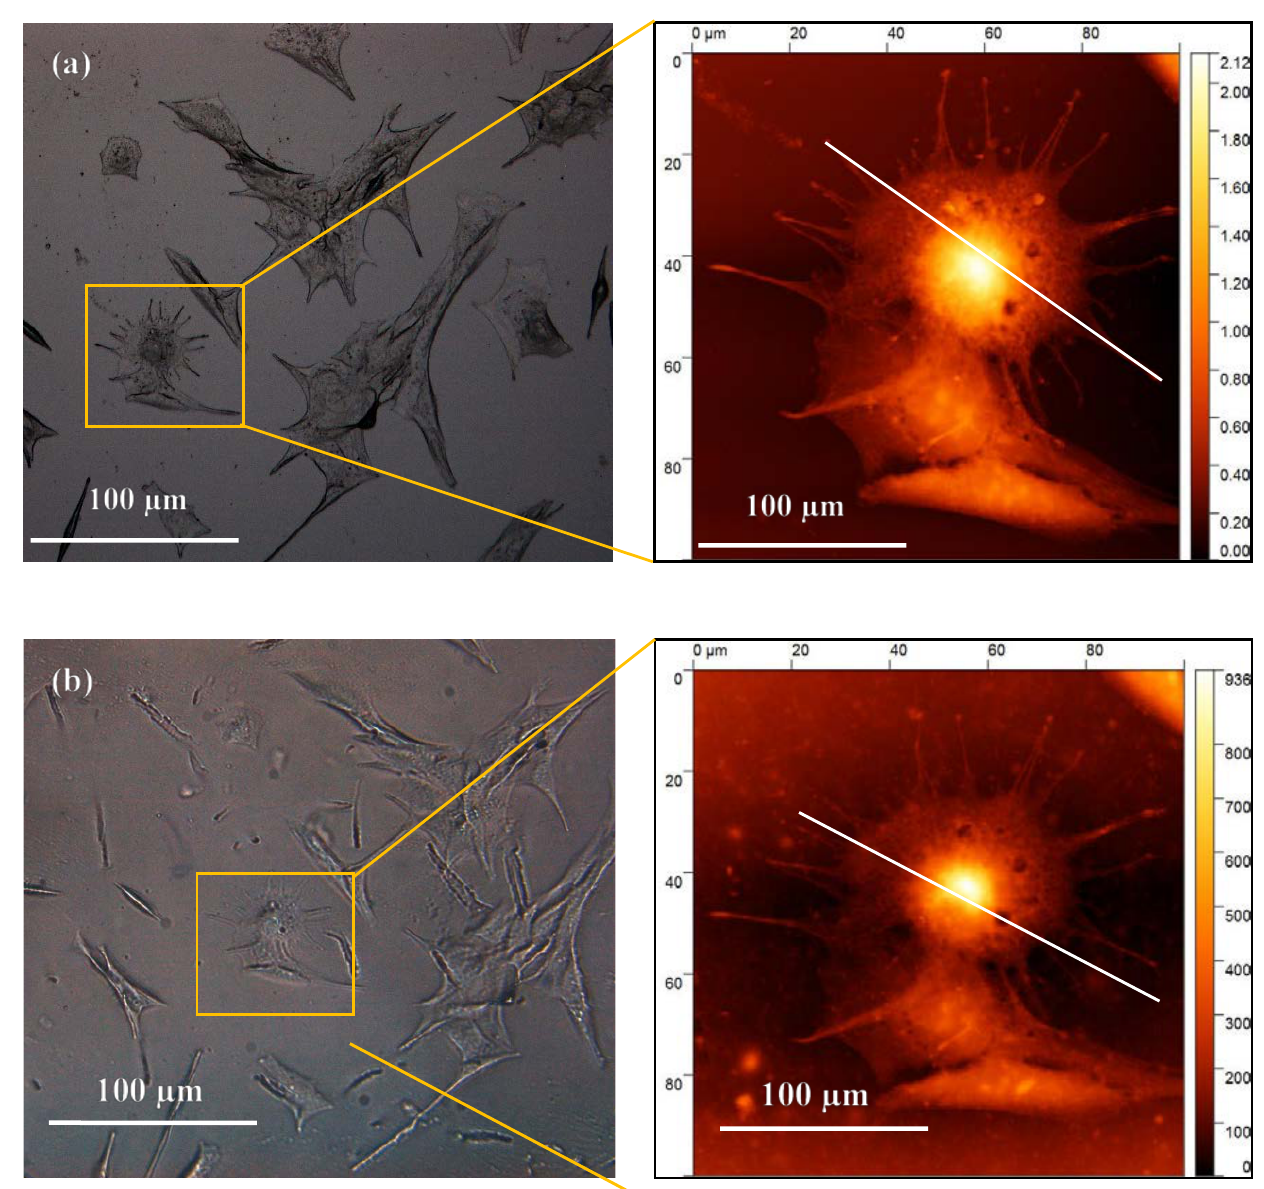
Figure 4. On the left, optical micrographs of ( a ) fixed C2C12 cells on glass and ( b ) positive replication in 4% conductive hydrogel. On the right are the AFM images of a single cell on the same substrates. The white lines across the cell indicate the profile of the cross-section of the cell at each step, which are compared in the next figure.